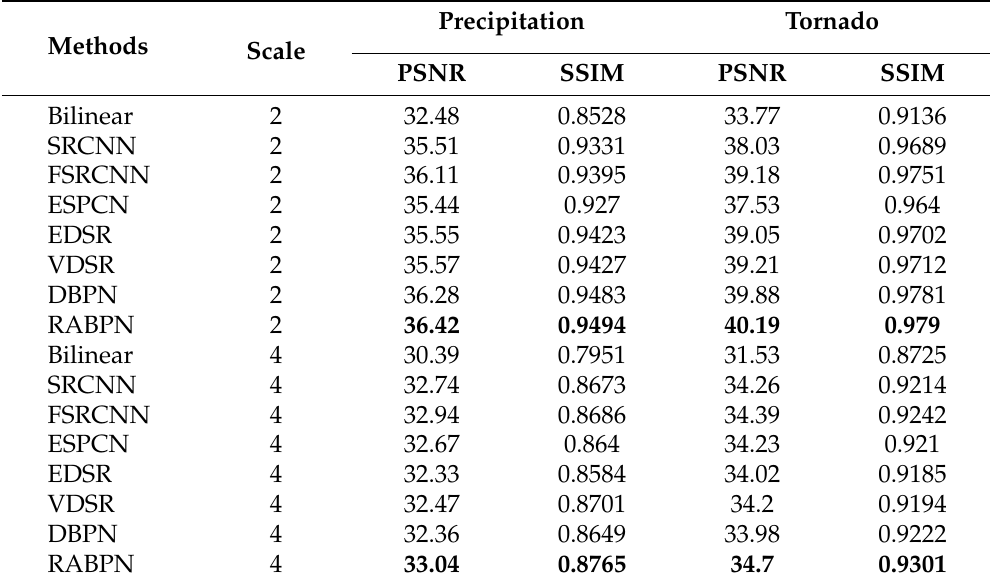
Table 4. Quantitative results with different methods in weather